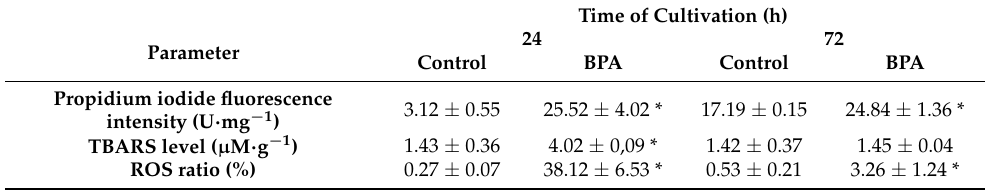
Table 2. The effect of BPA on M. roridum IM 6482 membrane permeability (expressed as propidium iodide fluorescence in fungal biomass), lipid peroxidation (expressed as TBARS level) and ROS ratio (%) after 24 and 72 h of culturing in Czapek-Dox III medium containing 50 mg · L − 1 of BPA. Asterisks represent values with statistically significant differences determined with a one-way ANOVA followed by the Tukey test ( α = 0.05) for different